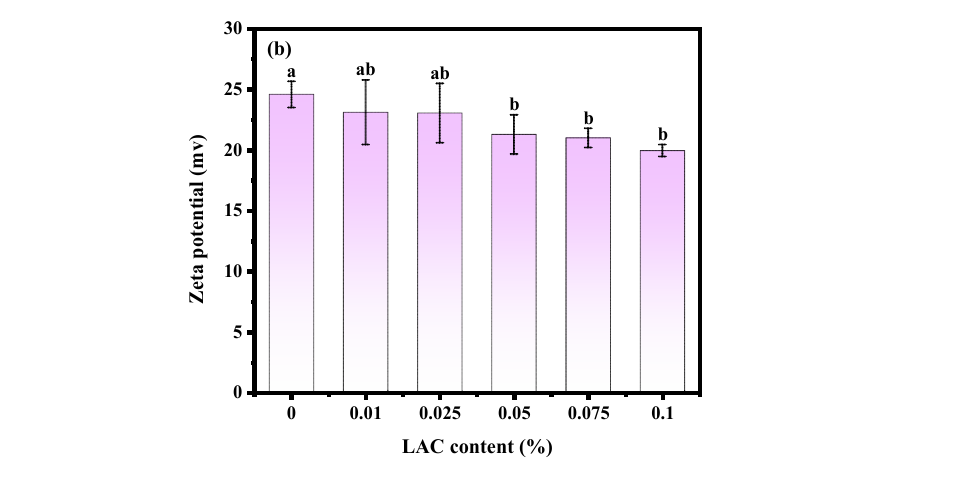
Figure 5. PCA plot showing the attribution of soy yogurt groups over LAG addition with respect to sensorial characteristics. (SY1 , 2 , 3 , 4 , 5 , 6 with 0% , 0.01% , 0.025% , 0.05% , 0.075% and 0.1% LAG concentration, respectively).